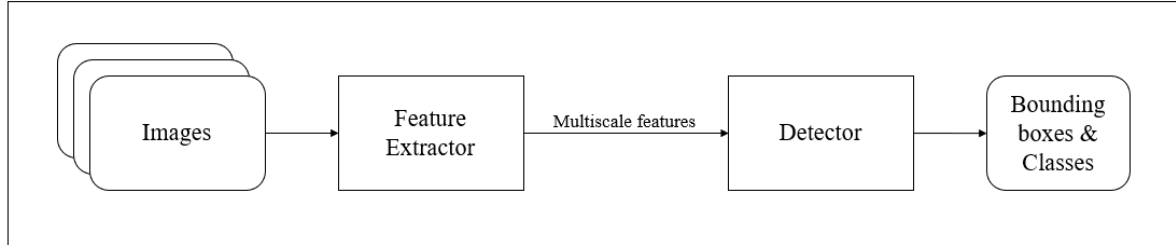
Figure 4. YOLOv3 network architecture.